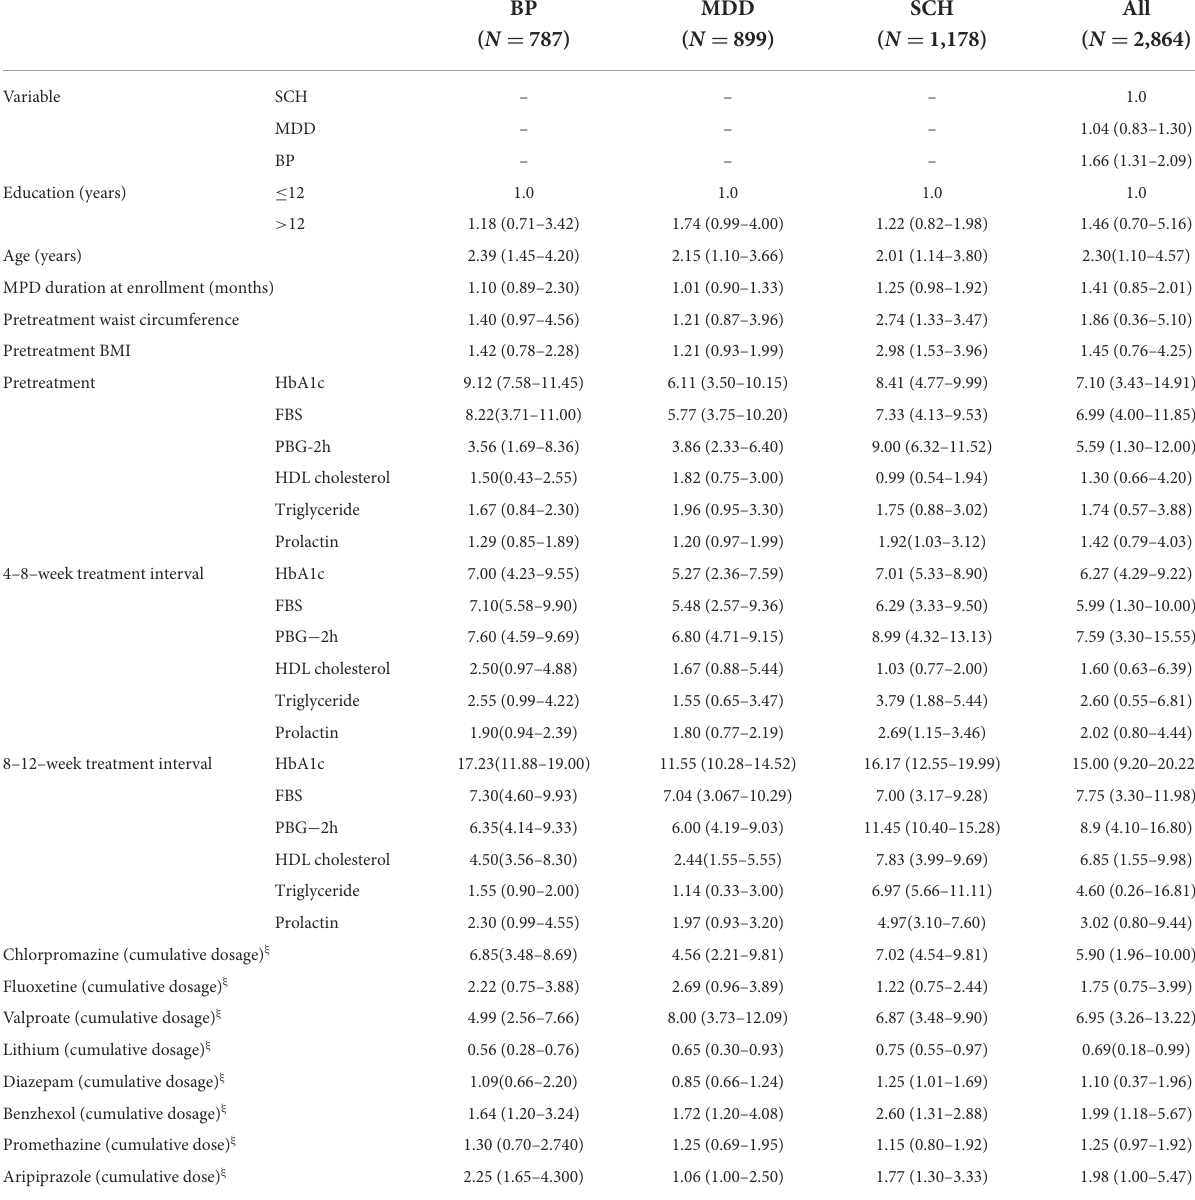
TABLE 3 Univariate analysis of risk factors of cognitive